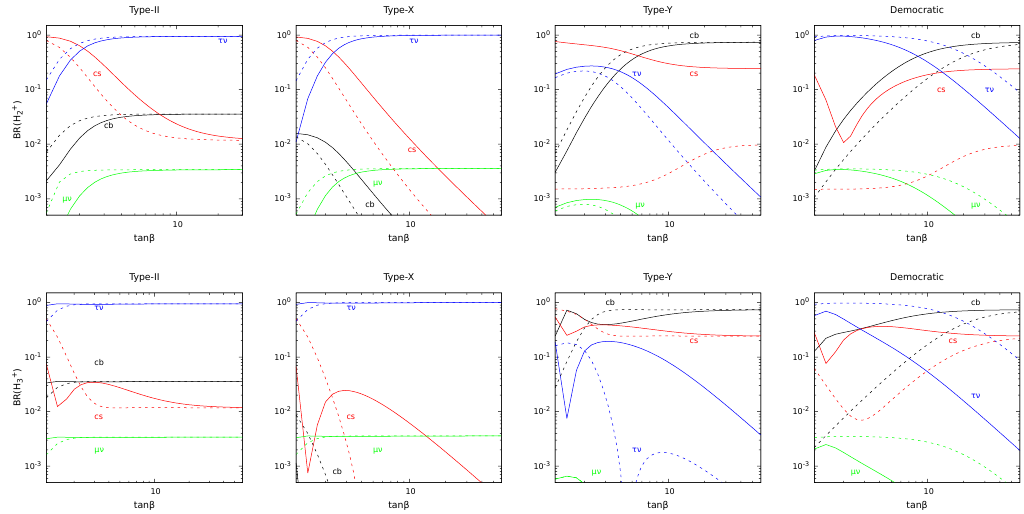
Figure 1 . BRs of H + (upper panels) and H + (lower panels) as a function of tan β in, from left to 2 3 right, the Type-II, -X, -Y, and Democratic 3HDMs. We take M = 100 GeV, M = 150 GeV, H + 2 H + 3 θ = − π/ 4 and δ = 0 . The value of tan γ is 2 (5) for the solid (dotted) curves.